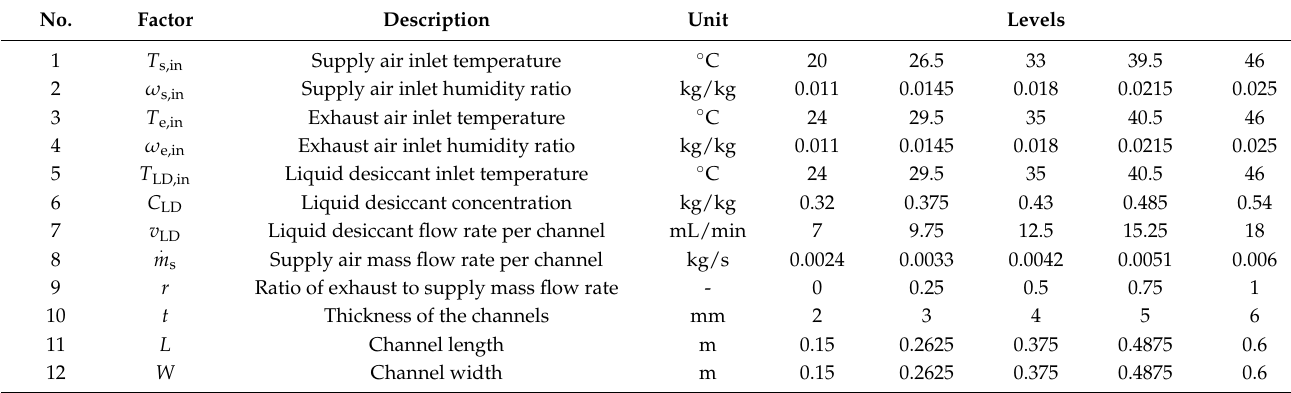
Table 2. The level of the factors in the